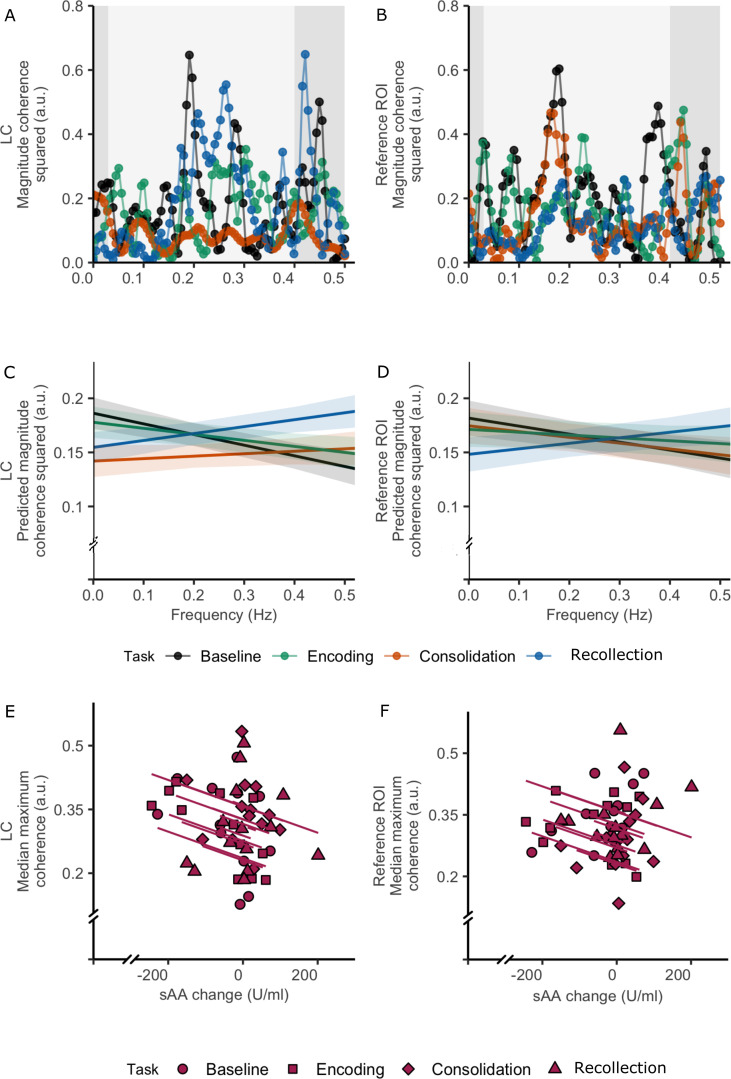
Coherence between LC and HRV across the task stages for the FIXed pipeline Note: Coherence between LC and HRV across the task stages.(A) LC coherence magnitude squared plotted against frequency for each task stage for a single participant. The high-frequency HRV band is depicted in a lighter shade. (B) Reference ROI-HRV coherence magnitude squared for the same participant. (C) The association between frequency and the predicted magnitude squared coherence between the LC and HRV across the various task stages (based on linear mixed effects models, N = 24 (7920 observations), p-values for all comparisons are provided in Supplementary file 5). Shaded regions in C and D show the 95% confidence intervals. (E) Repeated correlations between LC-HRV coherence and ΔsAA(Rrm(df)=−0.383 (34), p-value=0.021, CI (95%)=[−0.615,–0.013], N = 17, 56 observations). (F) Repeated correlations between the reference ROI-HRV coherence and ΔsAA (not significant, Rrm(df)=0.208 (34), p-value=0.223, CI (95%)=[−0.14, 0.51], N = 17, 56 observations).